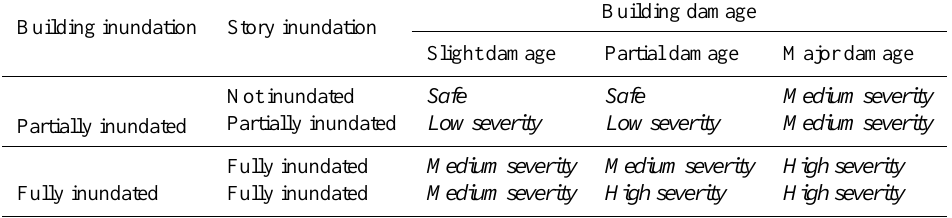
Table 3. Flood severity